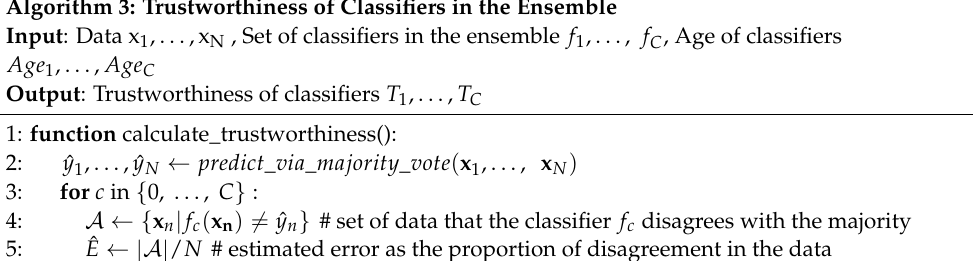
Algorithm 3: Trustworthiness of Classifiers in the